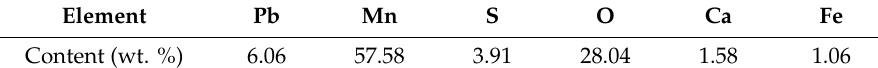
Table 1. Elemental composition of the electrolytic manganese anode mud (wt. %).